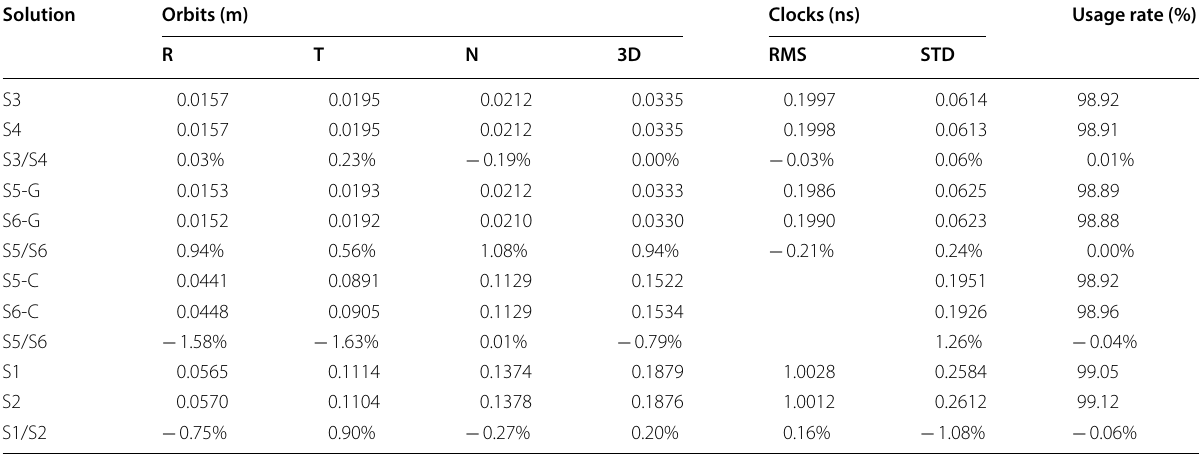
Table 2 Orbit and clock accuracy and data usage rate compared with WUM (BDS-3) and IGS (GPS) products